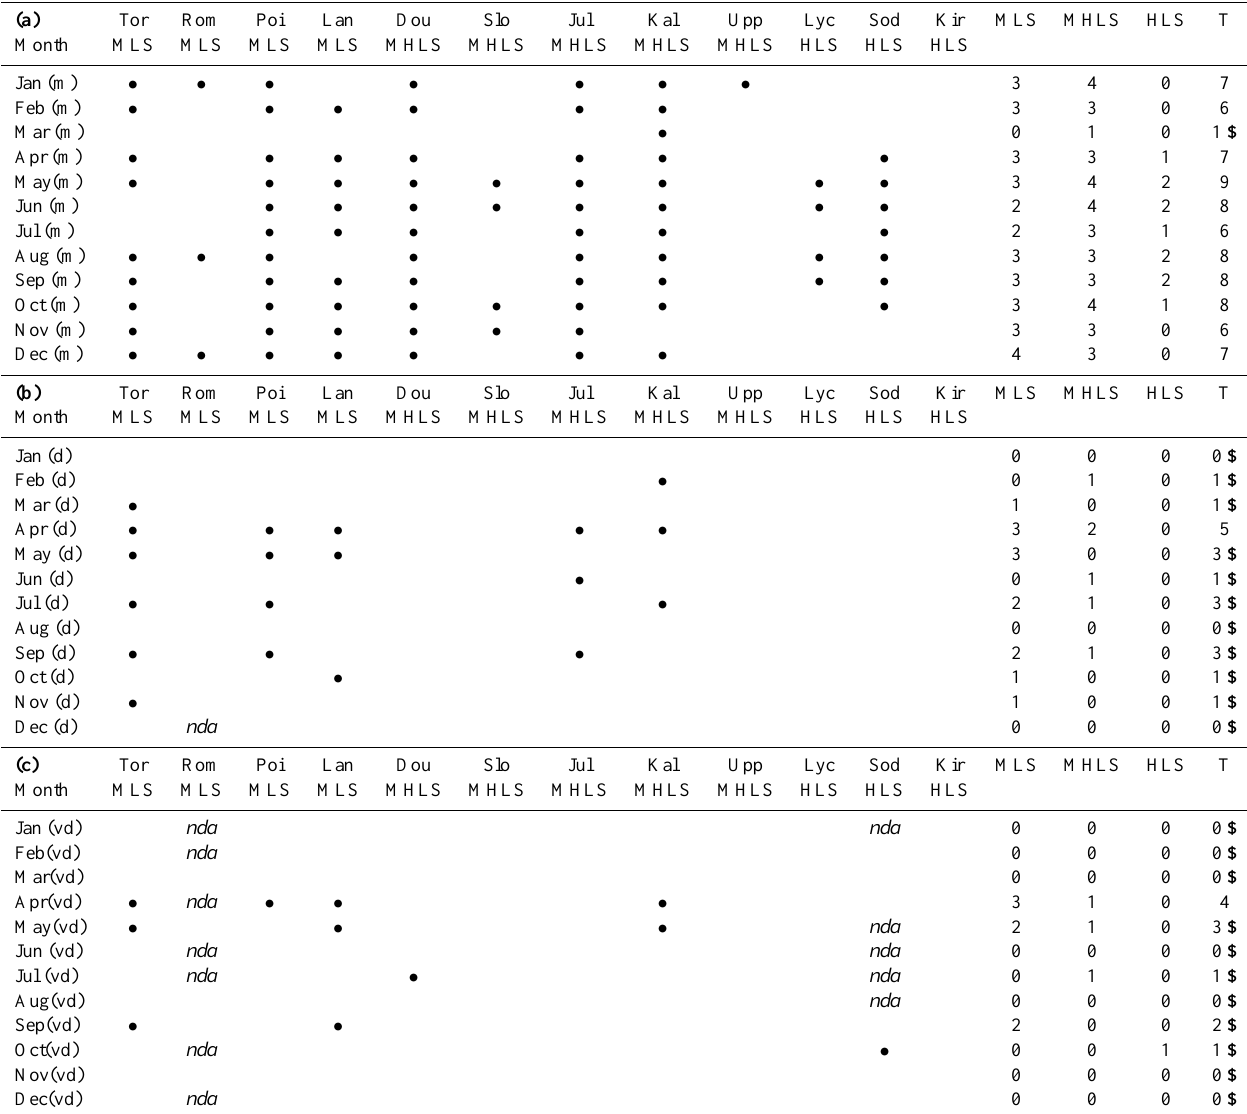
Table 2. The sites where the best performance is provided by the prediction model (2) are indicated with the full circle and shown for each month under moderate (m), disturbed (d), and very disturbed (vd) geomagnetic conditions. In these sites the different local models can be considered simultaneously operative for forecasting M3000F2 over Europe. The columns labelled with MLS, MHLS, and HLS show the number of sites operating simultaneously located at middle (40 ◦ N ≤ λ ≤ 50 ◦ N), middle-high (50 ◦ N < λ ≤ 60 ◦ N), and high latitudes (60 ◦ N < λ ≤ 70 ◦ N) respectively. The empty cells indicate cases that were discarded because the performance was worse than that of the others models. The values in the last column (T) indicate the total number of sites operating at the same time. The symbol $ indicates the cases in which the number of sites ( N < 4) operating simultaneously is not considered satisfactory to cover the area under investigation. The term nda indicates the cases for which it was not possible to evaluate the performance of the prediction model (2) with respect to the other models because no data were available to calculate the g.r.m.s.